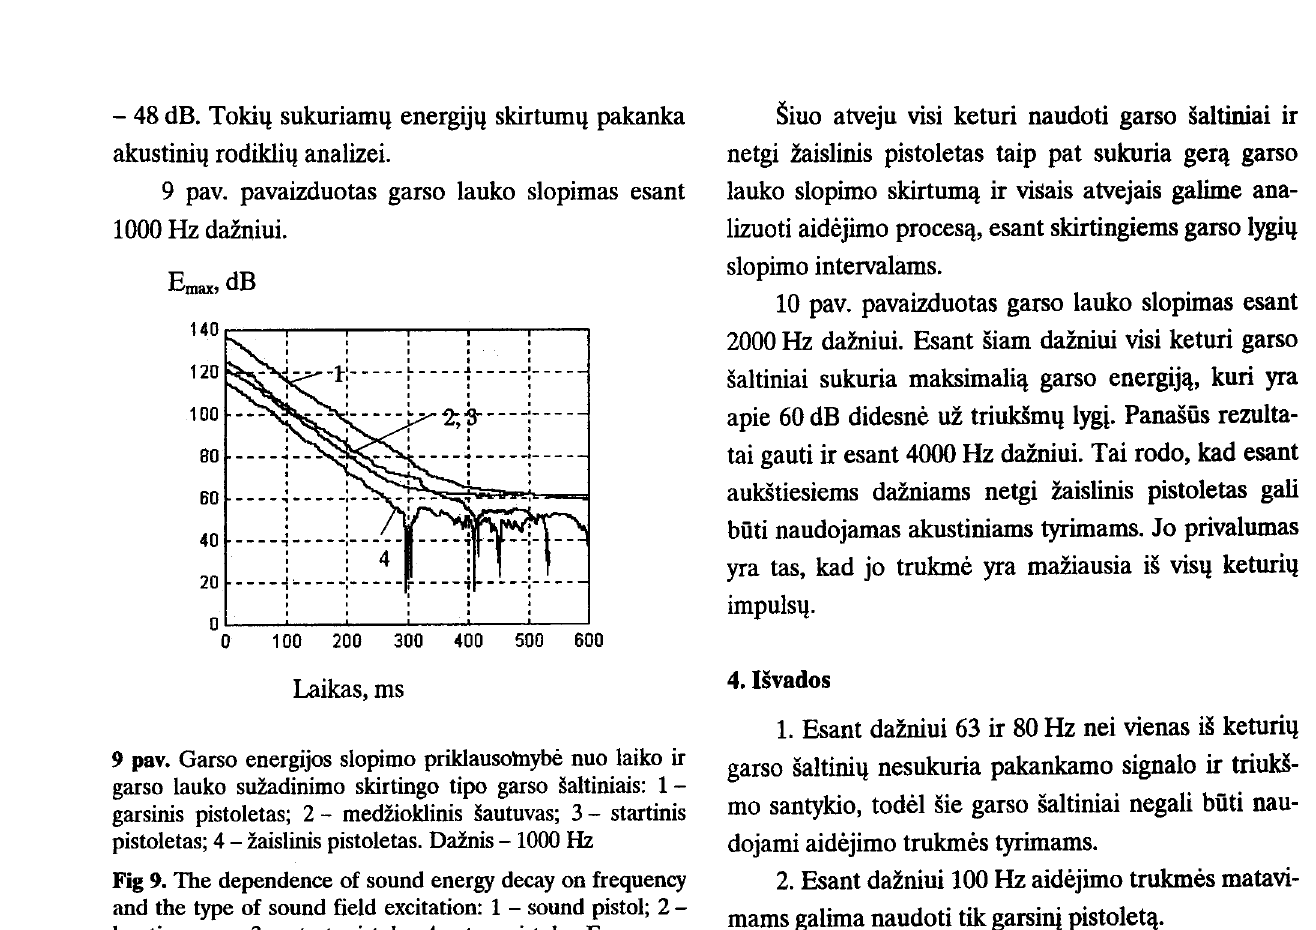
garsinis pistoletas; 2 - medzioklinis sautuvas; 3 - startinis pistoletas; 4 - zaislinis pistoletas. Damis - 1000 Hz Fig 9. The dependence of sound energy decay on frequency and the type of sound field excitation: 1 - sound pistol; 2 - hunting gun; 3 - start pistole; 4 - toy pistole. Frequency